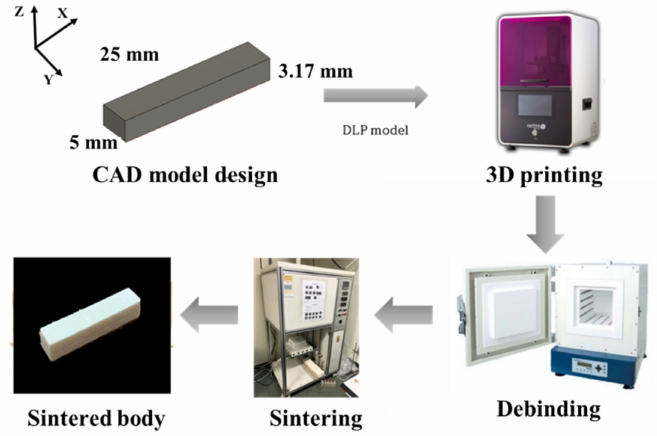
Figure 1. Flow diagram of the ceramic composite